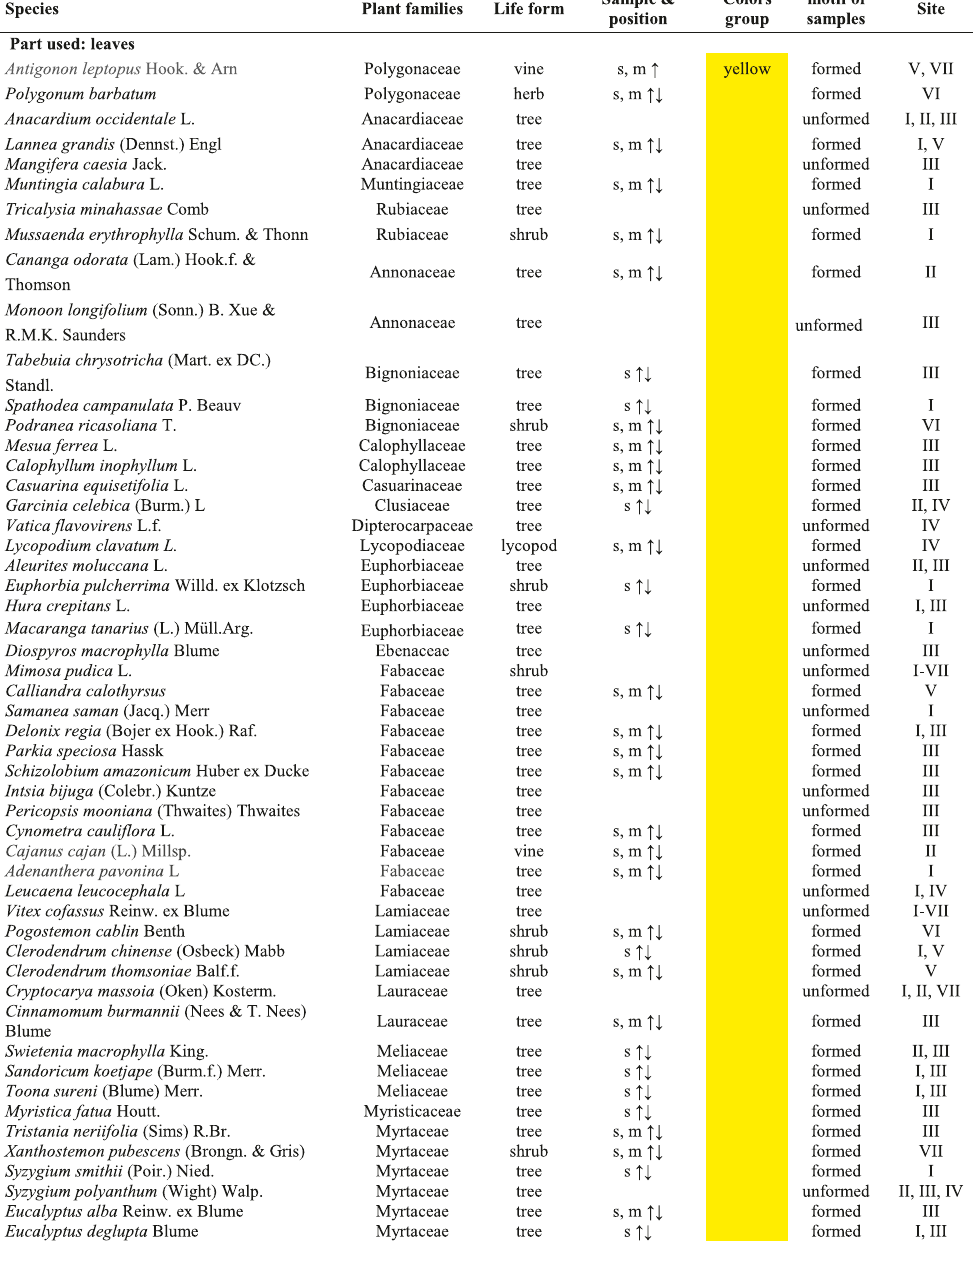
Table 1: List of flora, shoot (s), mature of the leaf (m), the color from the lower surface of the leaf to the fabric ( ↑ ), the color from the lower and upper surface of the fabric ( ↑↓ ), Hasanuddin University area, Makassar (I), the educational forest of Hasanuddin University area, Maros (II), the nursery of the Second Region of Forest Seed/Seedling Office, South Sulawesi, Gowa (III), Special Purpose Forest Area, Tabo-Tabo Forestry Education and Training, Pangkep (IV), Rammang-Rammang Tourism Karst, Maros (V), Leang Kado Karst, Maros (VI), and Kahu village forest, Bontocani, Bone